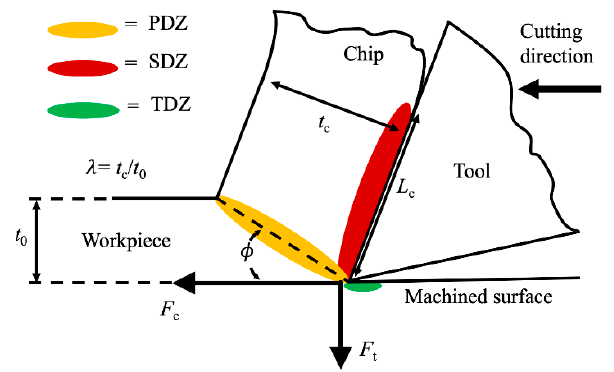
Figure 11. Schematic of the primary deformation zone (PDZ), the secondary deformation zone (SDZ) and the tertiary deformation zone (TDZ).